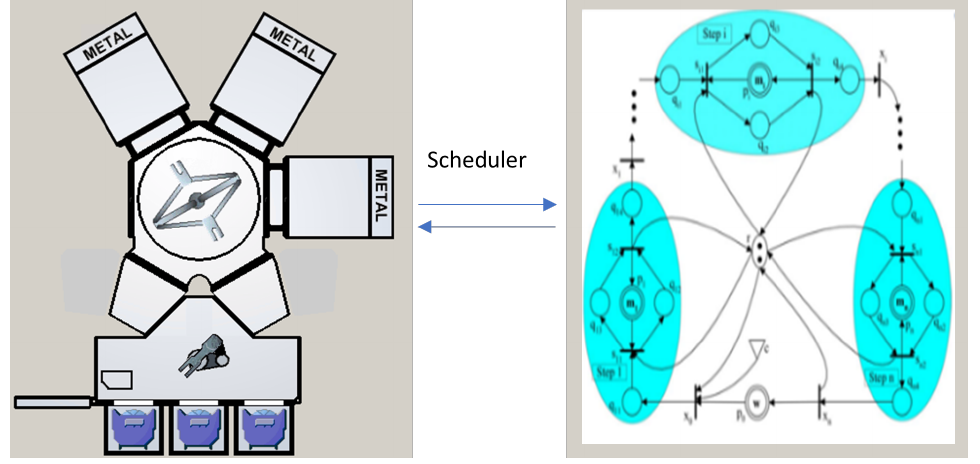
Figure 2. Petri net model of cluster tool